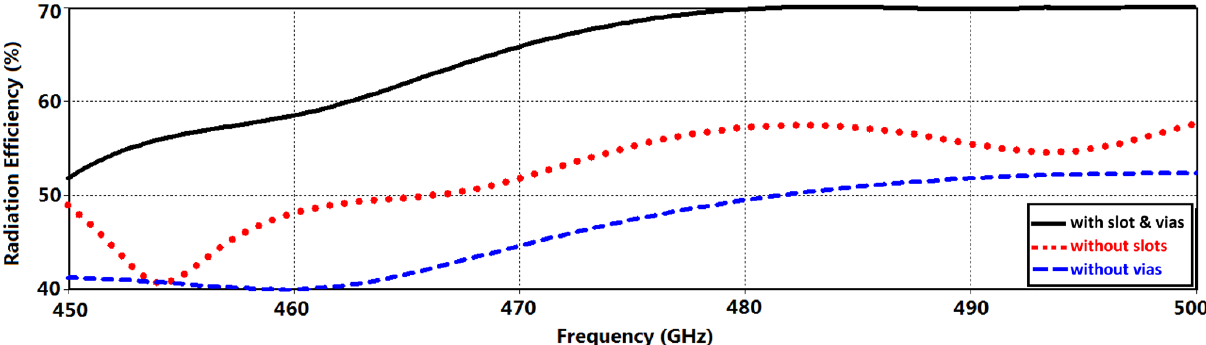
Figure 3. Radiation gain as a function of the frequency of the proposed AoC (i) without metamaterial slots, (ii) without metallic vias, and (iii) with metamaterial slots and metallic vias.